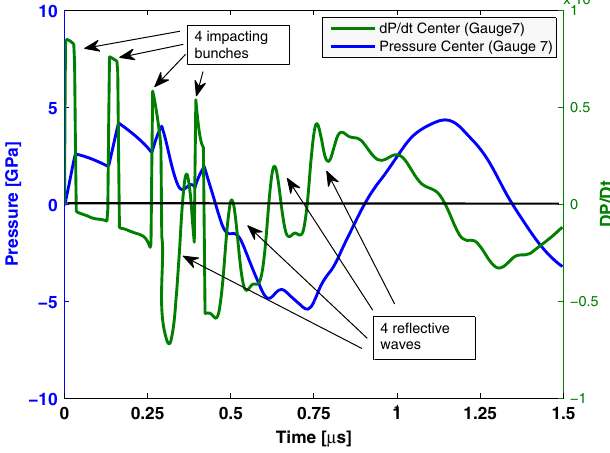
FIG. 9. Plot of the pressure response (blue) and its time derivative (green) in the center of the target core (gauge 7) during the first 1 . 5 μ s after proton pulse impact. The plot clearly shows the discontinuities in the pressure derivative corresponding to the beginning and end of each of the four proton bunch impacts, the produced tensile wave at the end of the bursts, and four delayed waves, corresponding to the reflection of the four bunch impacts. This simulation is considering a J-C strength model for the tungsten target